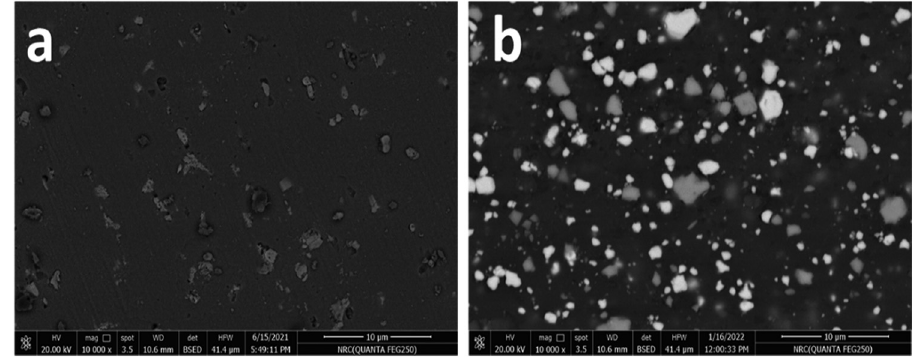
Figure 6: SEM images of the ( a ) AA2024/TaC monocomposite and ( b ) AA2024/TaC_NbC hybrid composite.